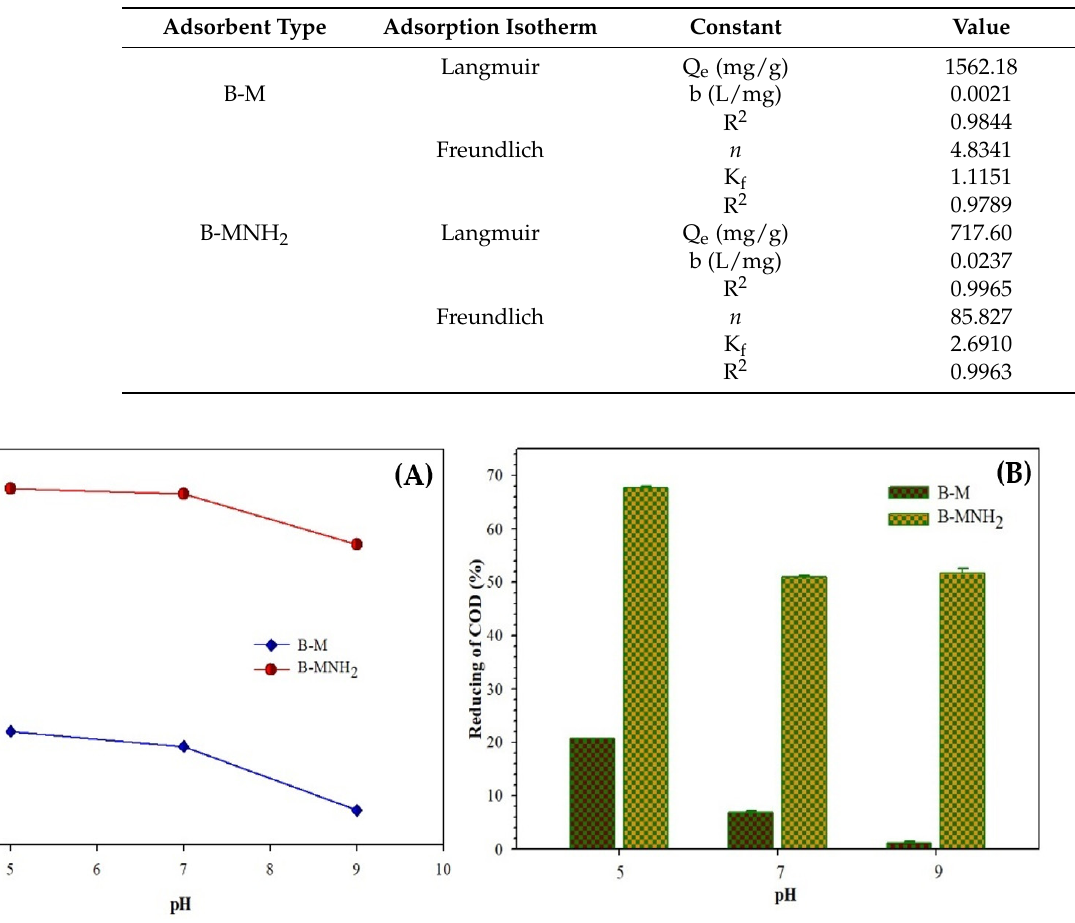
Figure 7. ( A ) Pb(II) ion adsorption capacity and ( B ) percentage of COD reduction of the adsorption process at varying pH with an adsorbent mass of 60 mg, a sample volume of 300 mL, and a stirring speed of 150 rpm for 360 min.